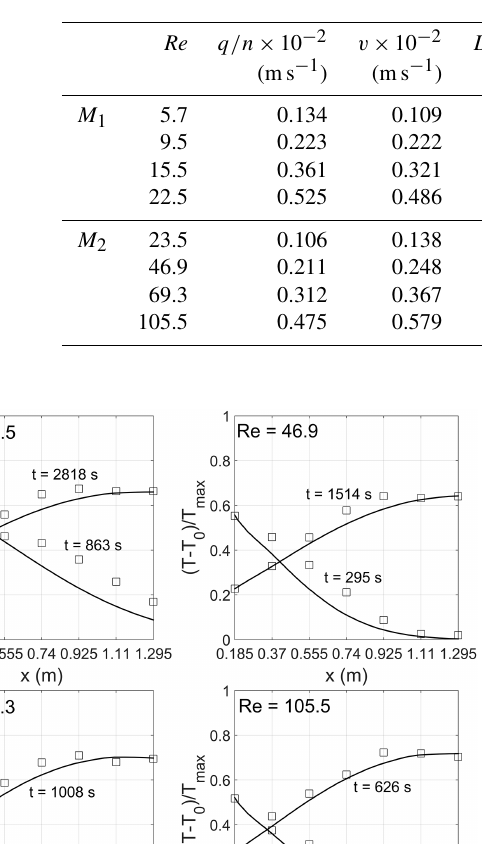
Table 2. Estimated values of parameters for LTNE model for different Re values.